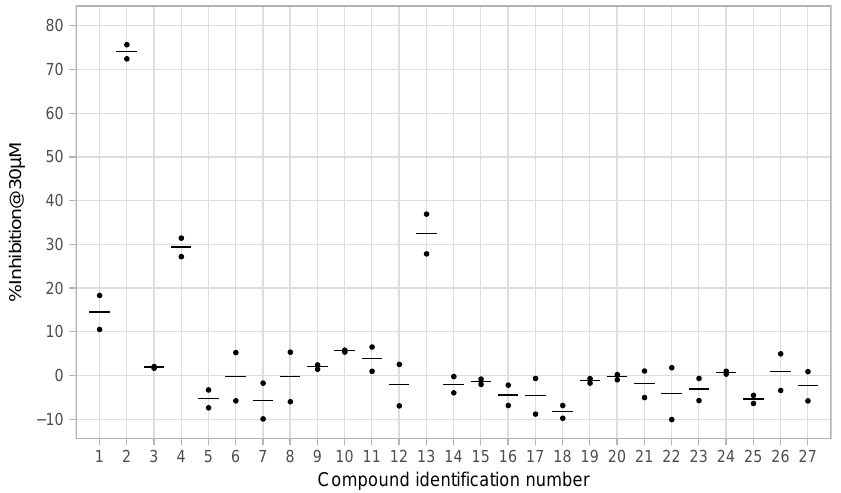
Figure 3. Preliminary measurements of eEF2K inhibitory activities of selected 27 compounds. Black dots indicate values for duplicate measurements and crossbars indicate mean values for each compound.